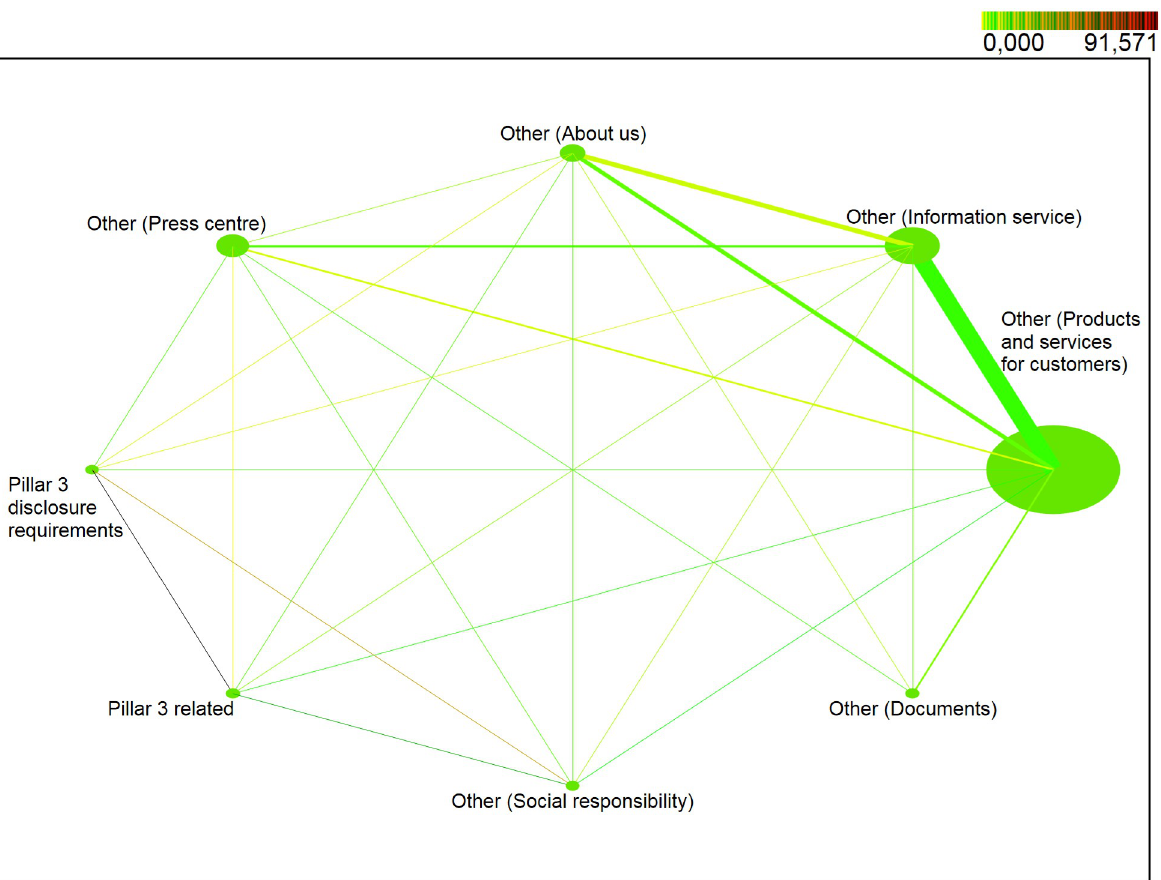
Fig 6. Visualization of frequented web parts of the third quarter of